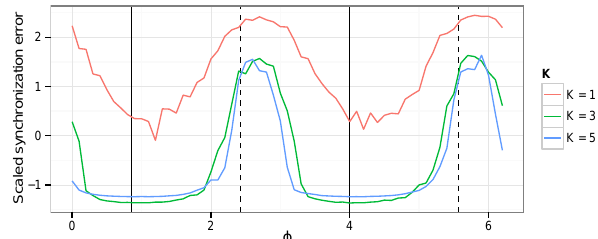
Fig. 3. Cross-section of ϕ versus the scaled synchronization error for several K values at θ equal to 1.5. The solid vertical lines show the position of the first EOF axis, the dashed vertical line that of the third EOF